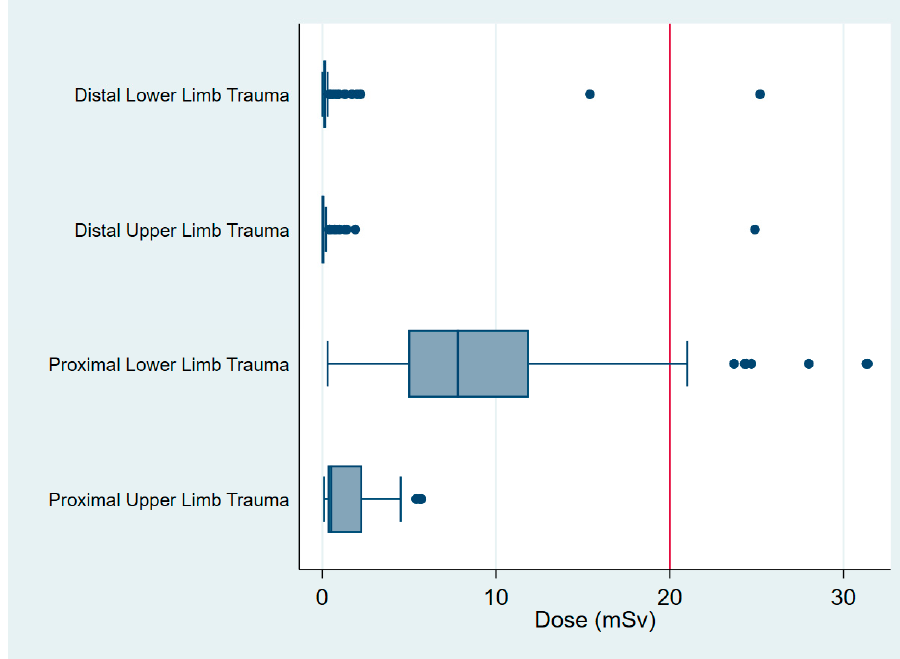
Figure 2. Radiation exposure by location. Table 4. Dose by procedure.